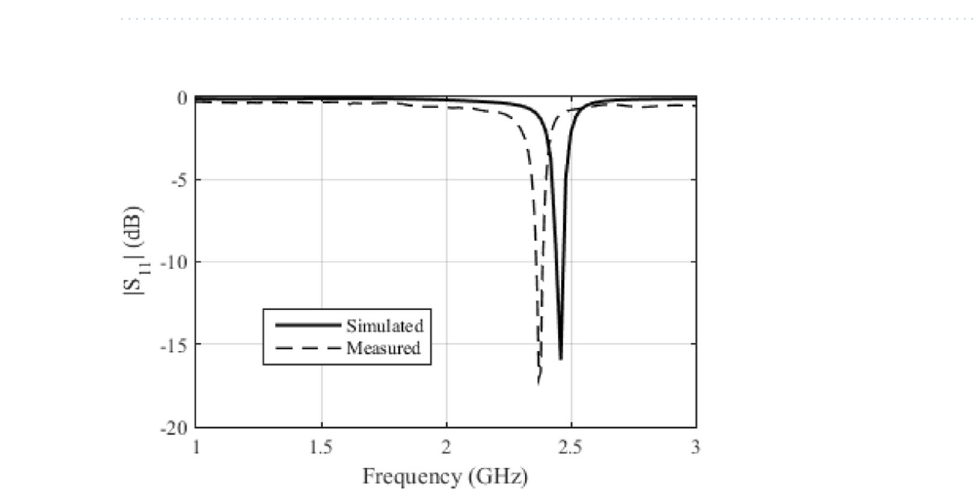
Figure 6. S 11 for the antenna arrays 2 and 3 constructed.